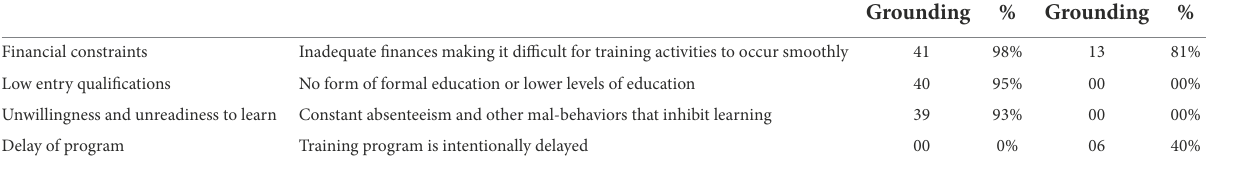
TABLE 3 Analysis of the weaknesses in informal training and sustainable livelihood of unemployed youths.